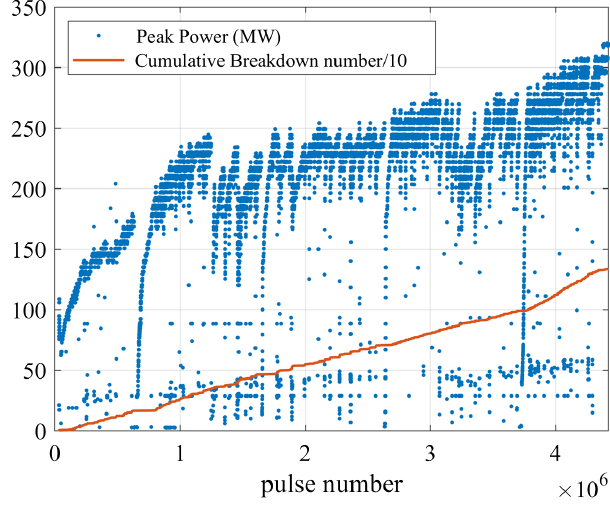
FIG. 14. Condition history of the two-stage pulse compression system at TPOT-X.